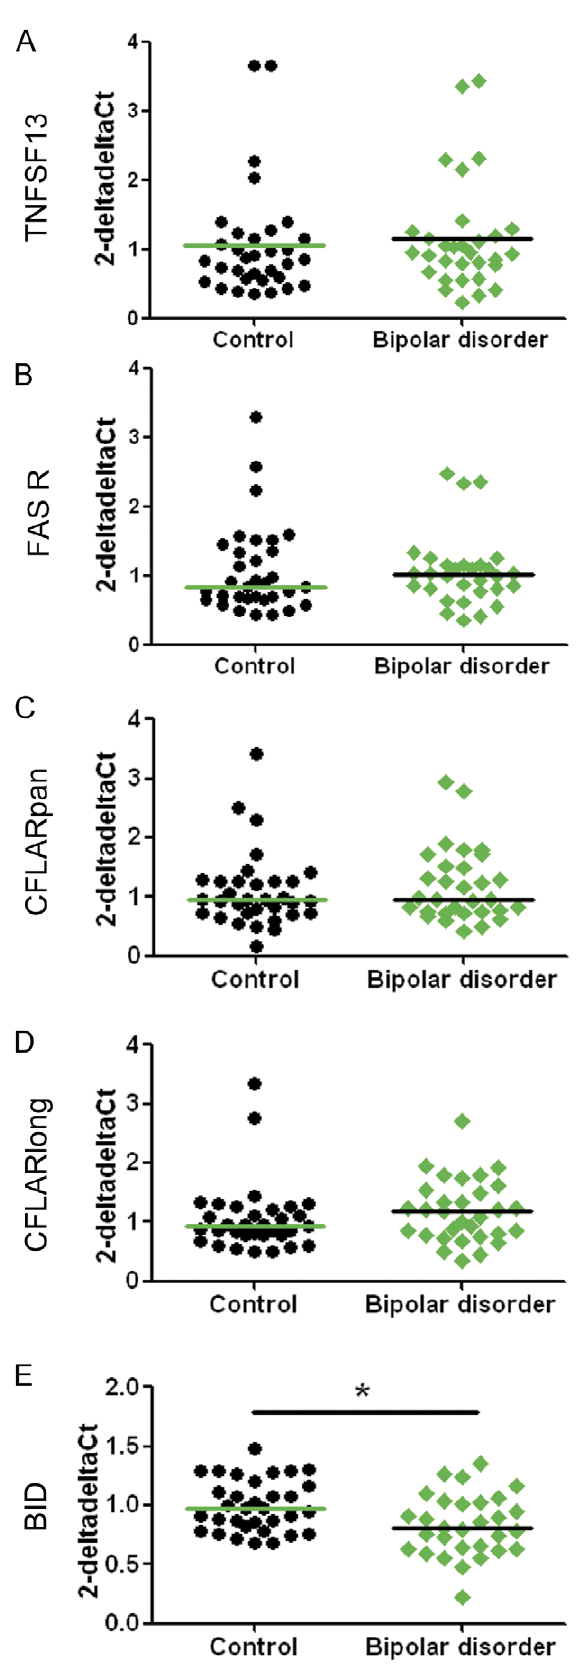
Figure 3. Gene expression levels of TNFSF13-FAS receptor pathway genes of interest relative to three housekeeping genes in dorsolateral prefrontal cortex from patients with bipolar disorder. cDNA samples obtained from the SMRI collection from individuals with bipolar disorder and unaffected controls were subjected to qRT-PCR. Expressions of TNFSF13 (A), FAS receptor (B), BID (C), CFLAR pan (D), and CFLAR long (E) relative to three housekeeping genes ( b -actin, TATA box binding protein and ubiquitin C) were calculated using the deltadelta Ct method. Horizontal lines indicate the population median, except for panel (E) where they indicate the mean as those data were normally distributed. * p ,